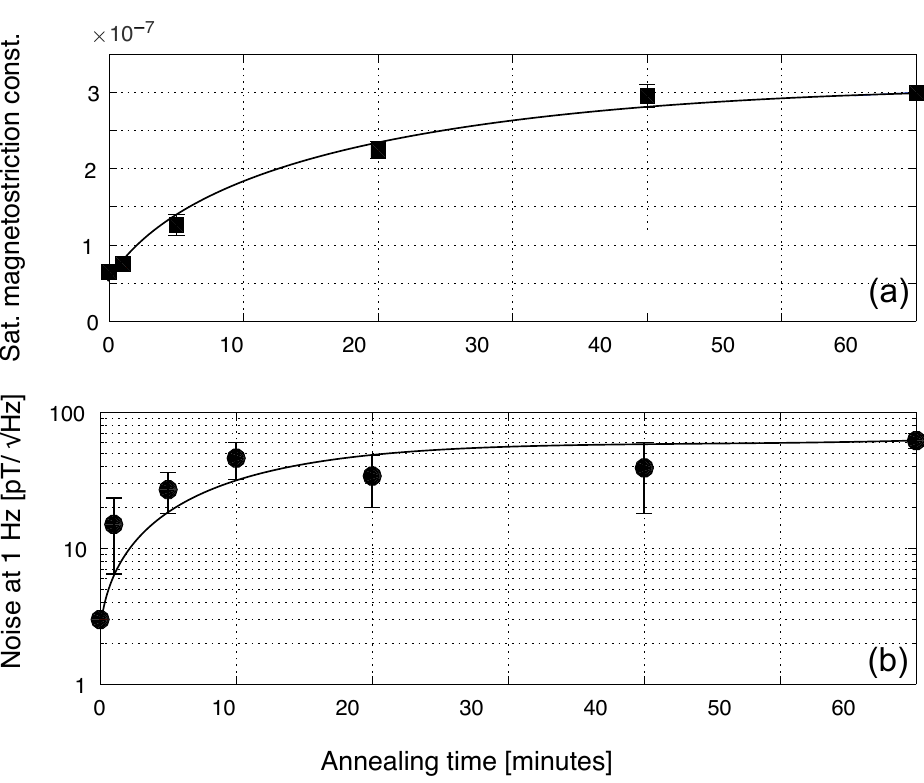
Figure 5. Saturation magnetostriction constant λ S ( a ) and noise ( b ) at 1 Hz of a wire with a nom- inal composition of ( Co 0.94 Fe 0.06 ) 72.5 Si 12.5 B 15 produced by the National Institute of Research and Development of Technical Physics of Iasi vs. annealing time, together with fitting